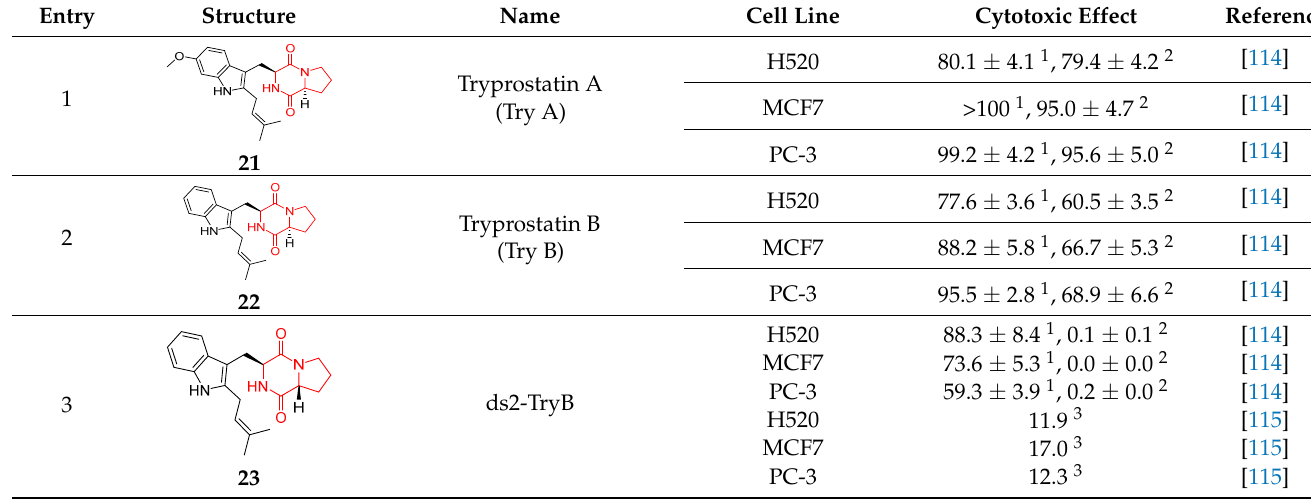
Table 2. Bicyclic proline ‐ based DKP modified with indole ‐ based side chains.